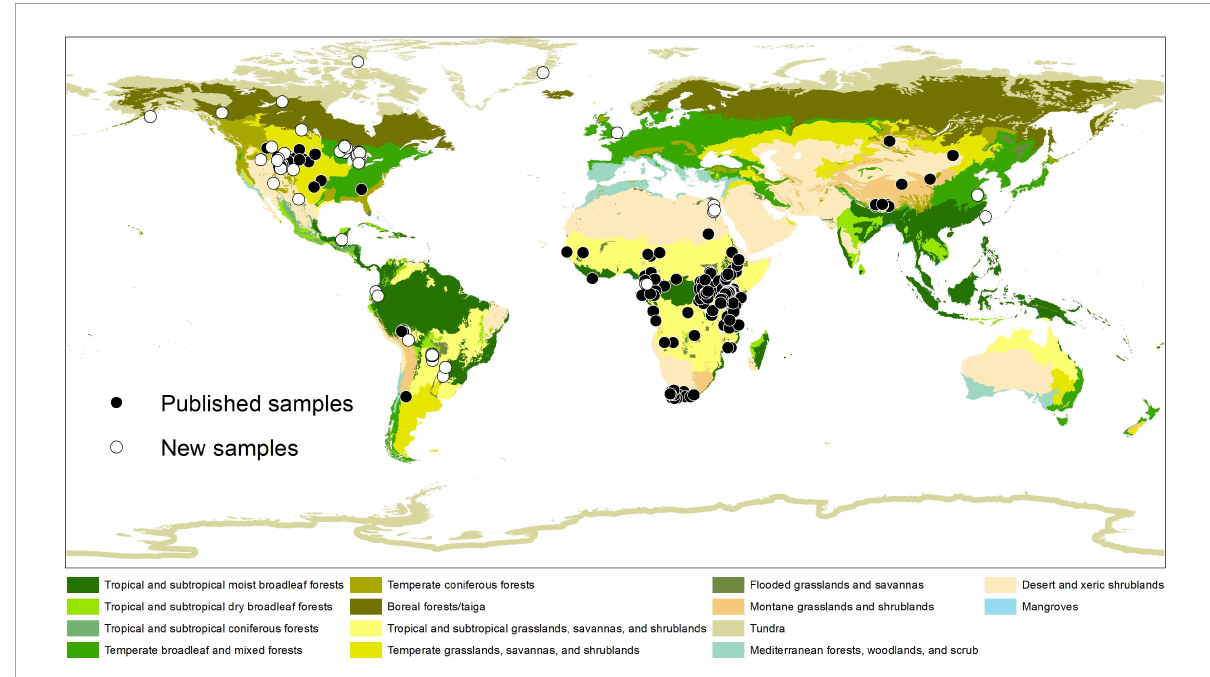
FIGURE1 Collecting locations of tooth enamel samples used in this study. Ecoregions of the world follow Olson et al. (2001). See Table 1 for sources of published samples. Note that sampling effort is highly uneven among geographic regions and ecoregions of the world.